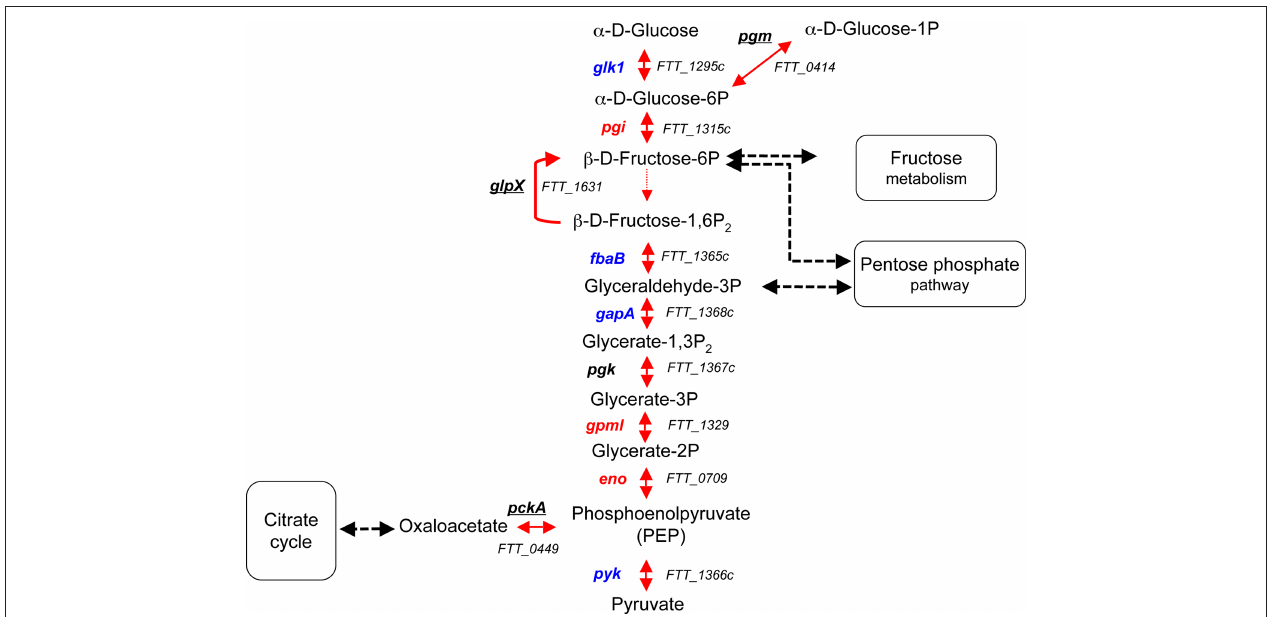
FiguRe 4 | The glycolytic and gluconeogenic pathways. GlpX is the only enzyme not promoting a reversible reaction. Genes that have been identified in genetic screens ( in vivo or in vitro ) are underlined. Genes that have not been hit in any screen are in blue. Genes predicted to be essential (according to